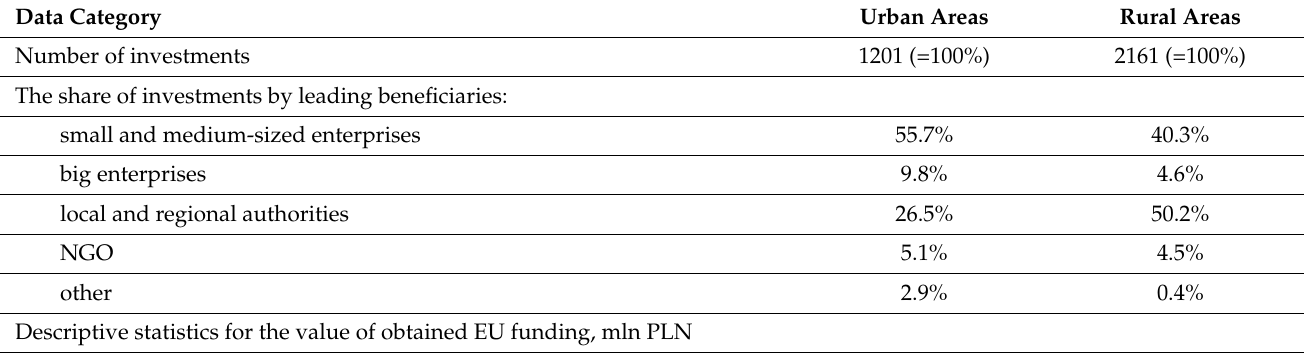
Table 6. The main rural–urban differences in absorption of 2014–2020 EU funding for solar RE